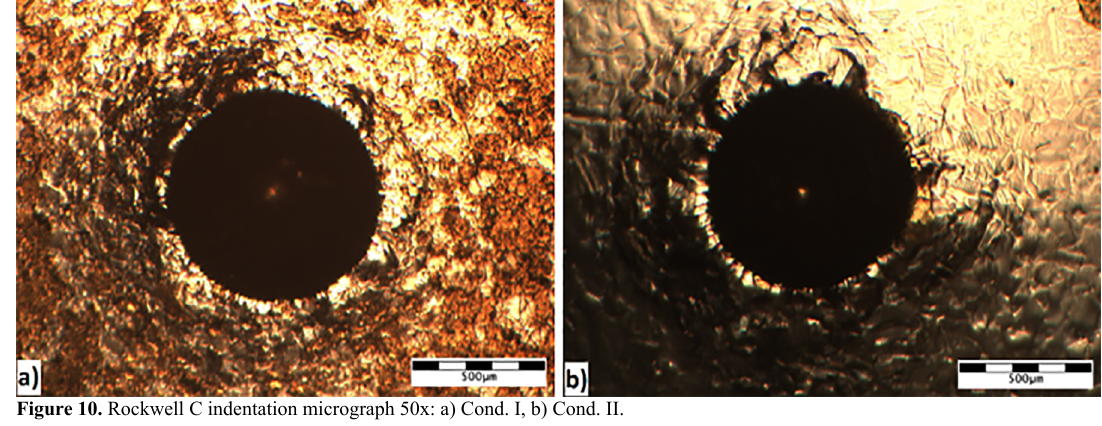
Figure 10. Rockwell C indentation micrograph 50x: a) Cond. I, b) Cond. II.